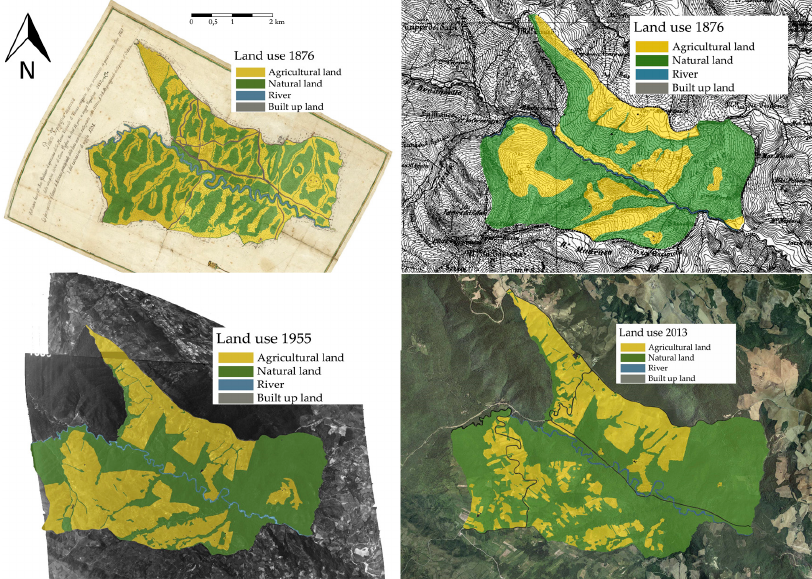
Figure 6. Spatial analysis of land use categories in different periods.